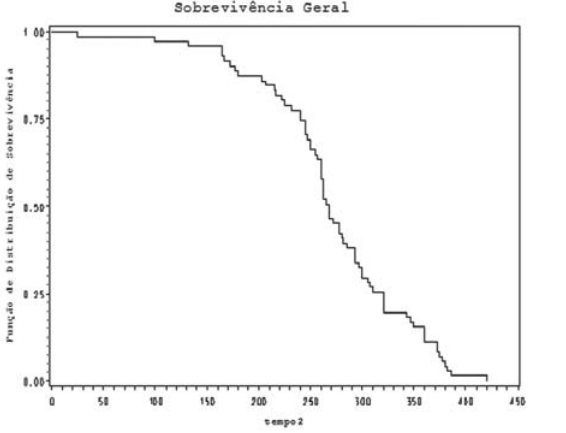
Fig. 2 - Sobrevivência Geral - tempo 2: T2 - Tempo Exato da Operação (minutos)